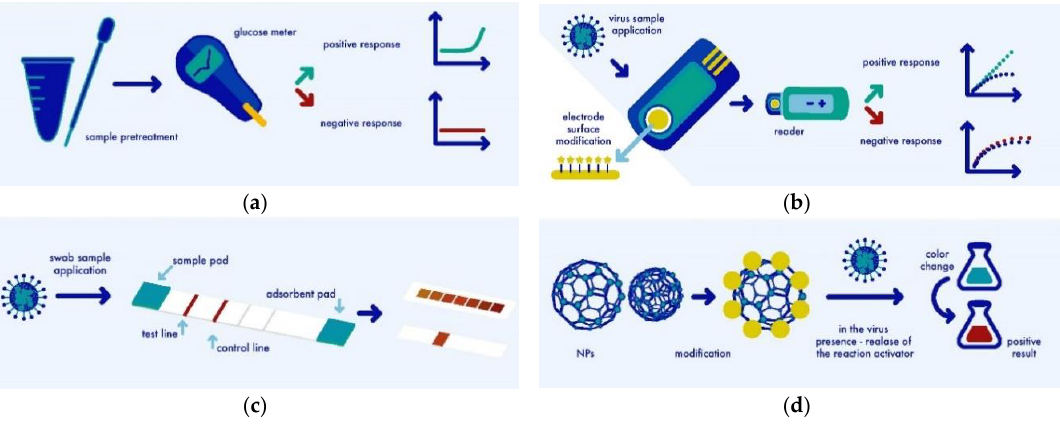
Figure 2. Different approaches for influenza virus detection: ( a ) Reuse of known devices like glucometers; ( b ) Electrical detection system; ( c ) Strip-based sensor/ ELISA modifications; ( d ) Optical approaches using nanoparticles.